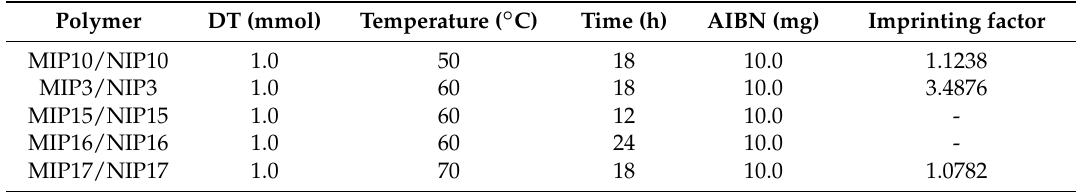
Table 2. The optimization of reaction temperature and time for the polymerization.